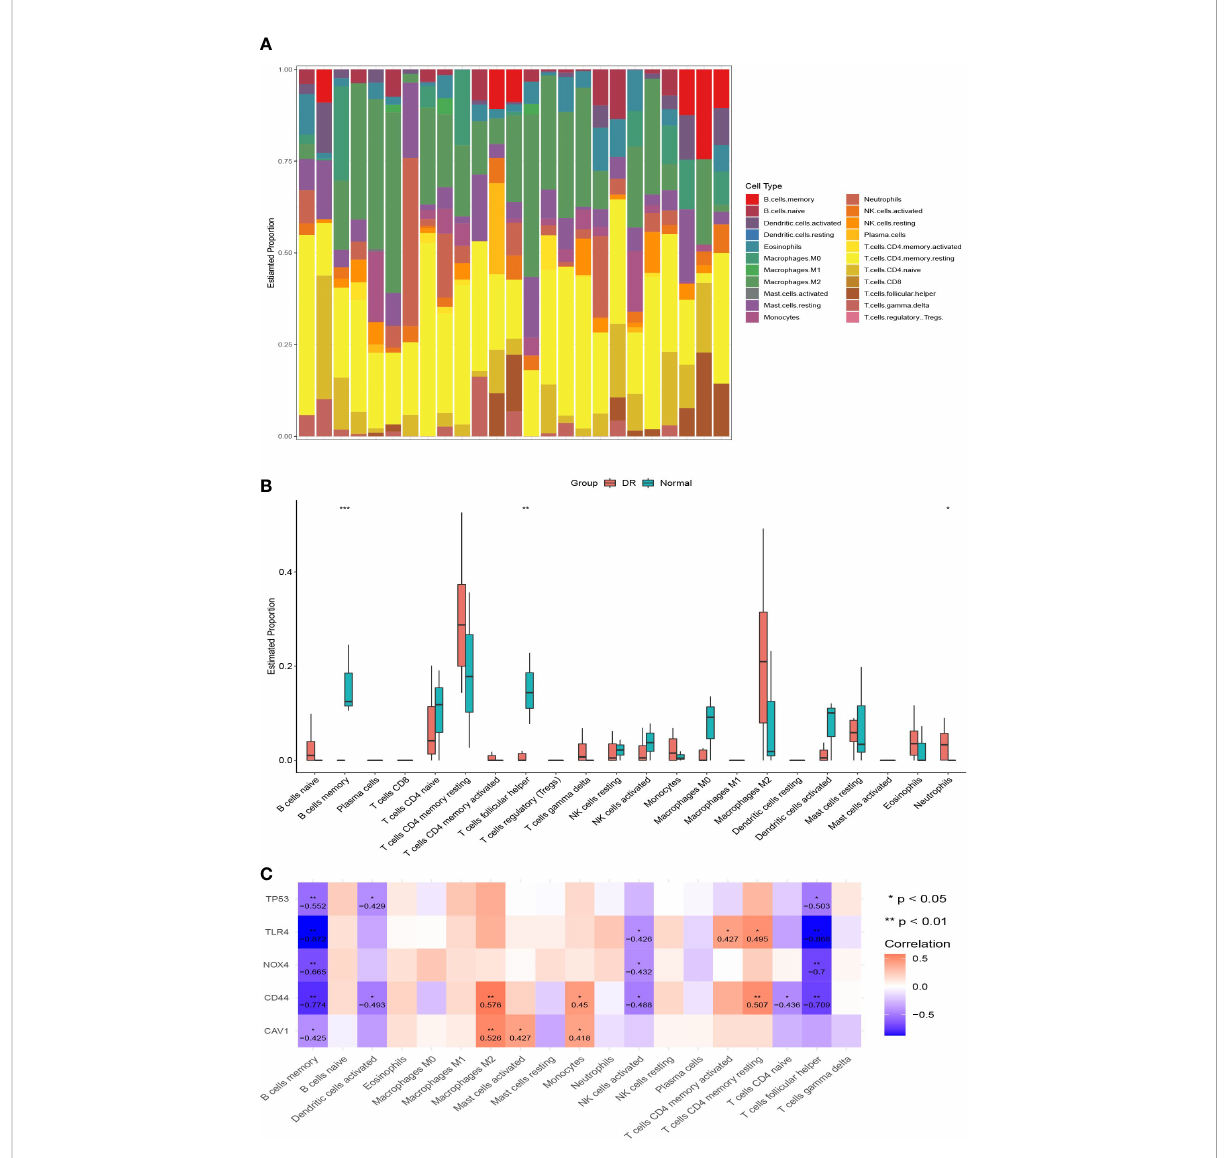
FIGURE 6 Immune in fi ltration analyses. (A) The histograms of 22 immune cell proportions in DR samples and normal samples. (B) The box plot of differences in immune in fi ltration in the two groups. * p < 0.05, ** p < 0.01, *** p < 0.001. (C) The correlation between ferroptosis-related hub gene expression and different immune cells; the numbers in the cell represent the correlation coef fi cient. DR, diabetic